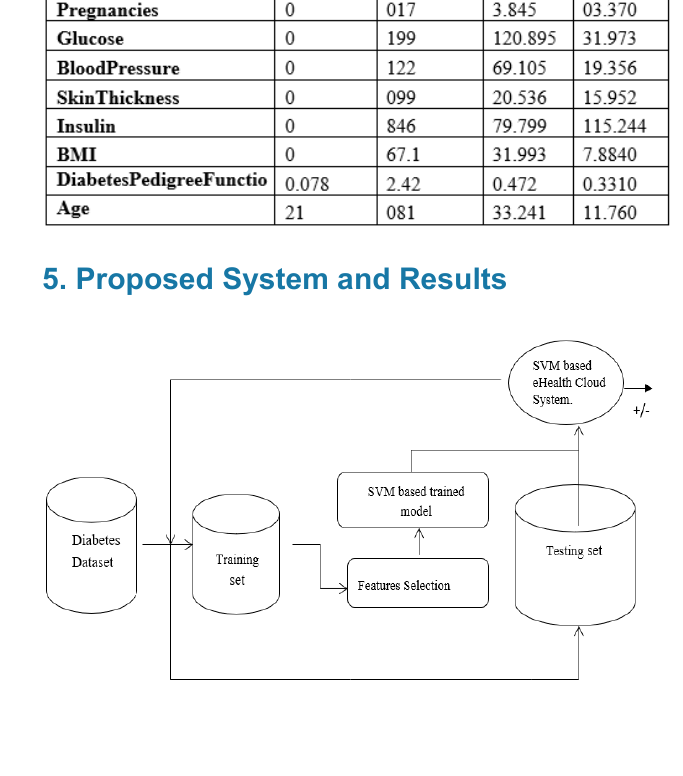
Figure 6. SVM eHealth